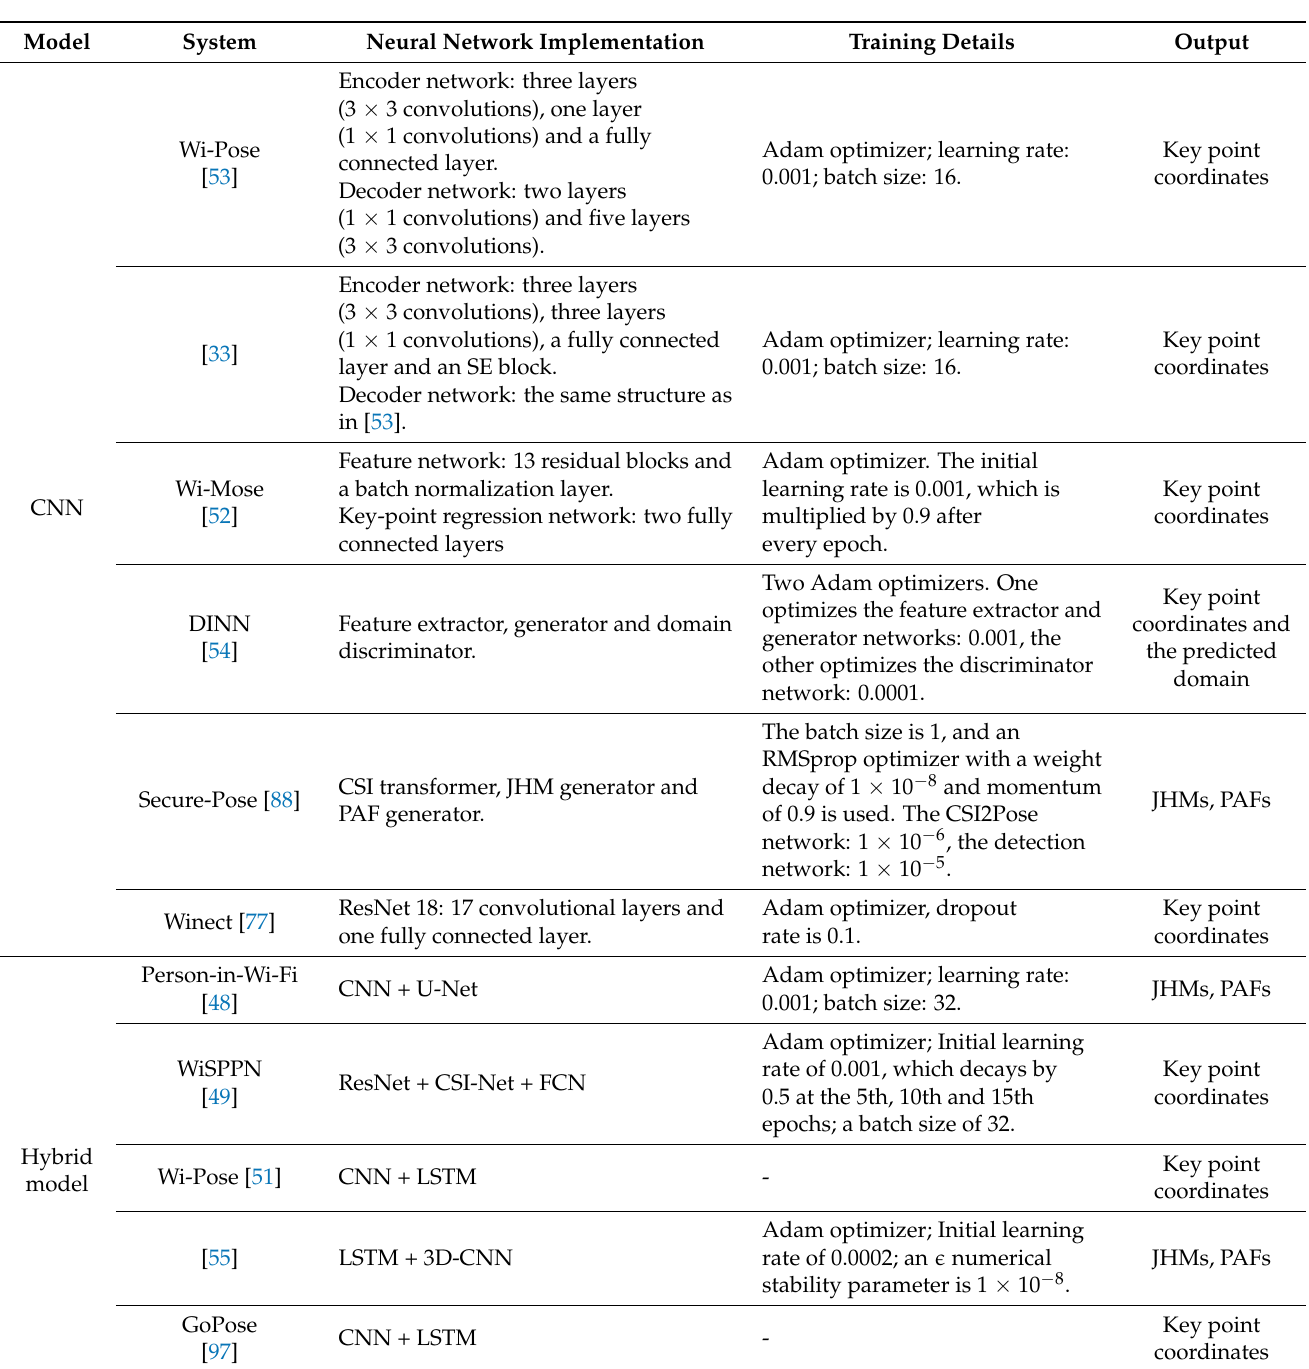
Table 3. Neural Network and Training